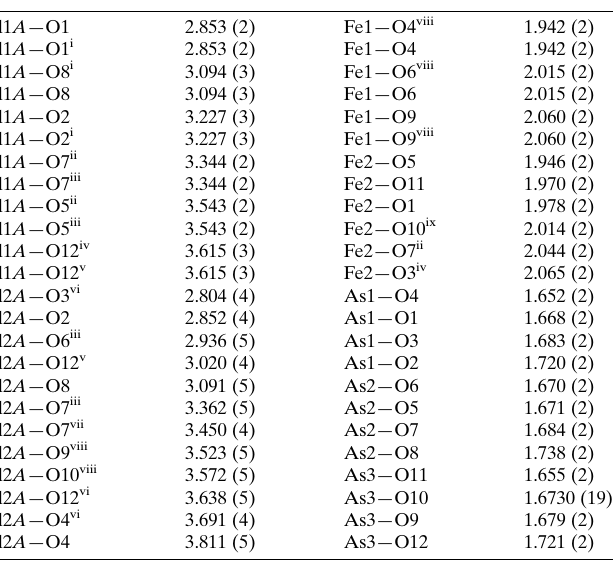
Table 5 Selected bond lengths (A˚ ) for TlFe(HAsO 4 ) 2